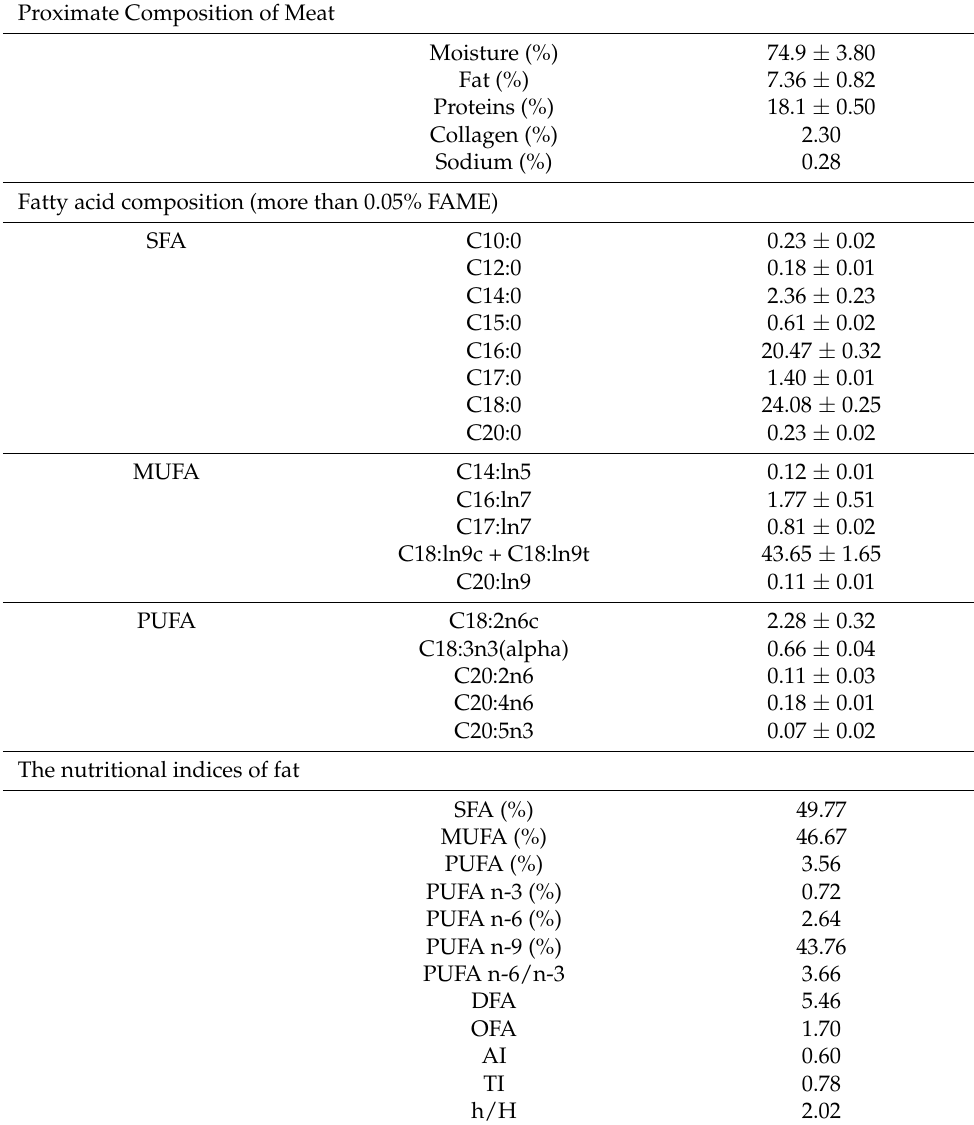
Table 2. Proximate and fatty acid composition of lamb (mean ± standard deviation). Proximate Composition of Meat Moisture (%) 74.9 ± 3.80 Fat